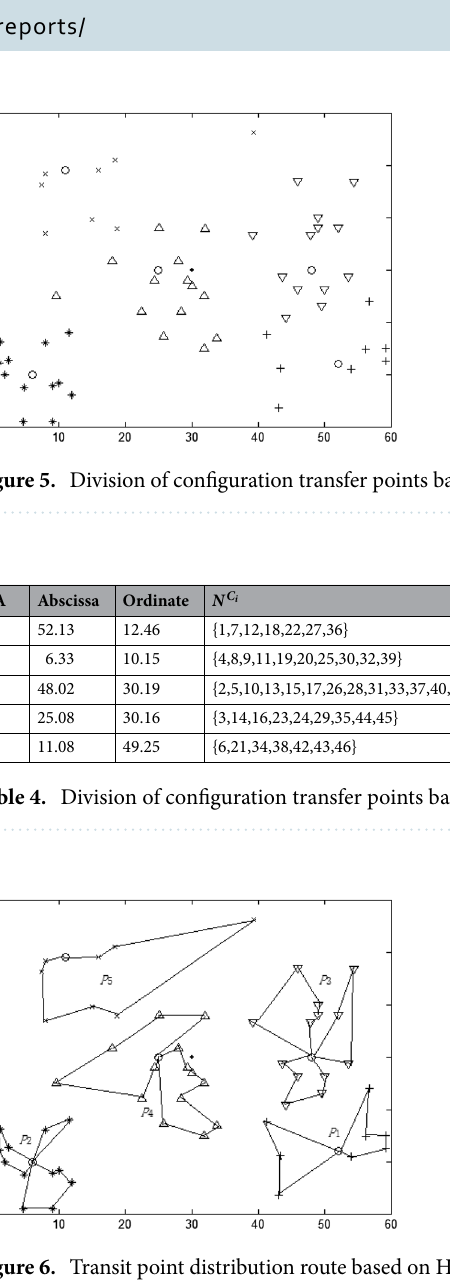
Figure 6. Transit point distribution route based on